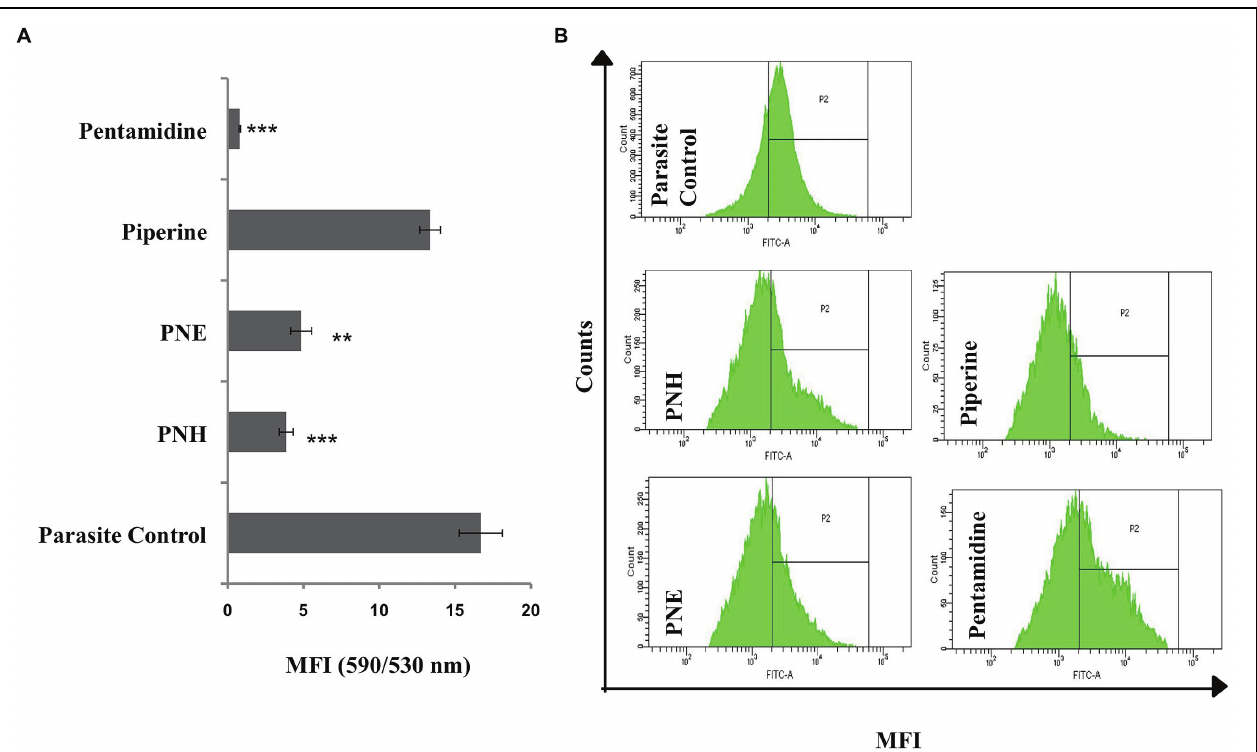
FIGURE 3 | Effect of Piper nigrum bioactive fractions on intracellular events leading to apoptosis. (A) Study of mitochondrial membrane depolarization. Leishmania donovani promastigotes (2 × 10 6 ml − 1 ) were incubated with different bioactive fractions or test compounds (500 μ g ml − 1 , 72 h, 22 ◦ C) and stained with JC-1 as described in methods. ∗∗∗ P < 0.001 and ∗∗ P < 0.01 in relation to parasite control. (B) ROS generation upon bioactive fractions treatment. ROS generation was monitored in L. donovani promastigotes (2 × 10 6 ml − 1 ) post 72 h of treatment (500 μ g ml − 1 ) with different bioactive fractions. Following acquisition of H 2 DCFDA stained parasites, the histograms were plotted where P2 gated region depicts shift in MFI. The shift in MFI was significant in case of PNH, PNE, and pentamidine ( P < 0.001) and non-significant in case of piperine ( P > 0.05) as indicated in